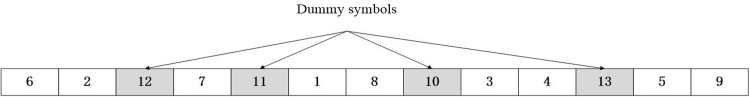
A random chromosome.